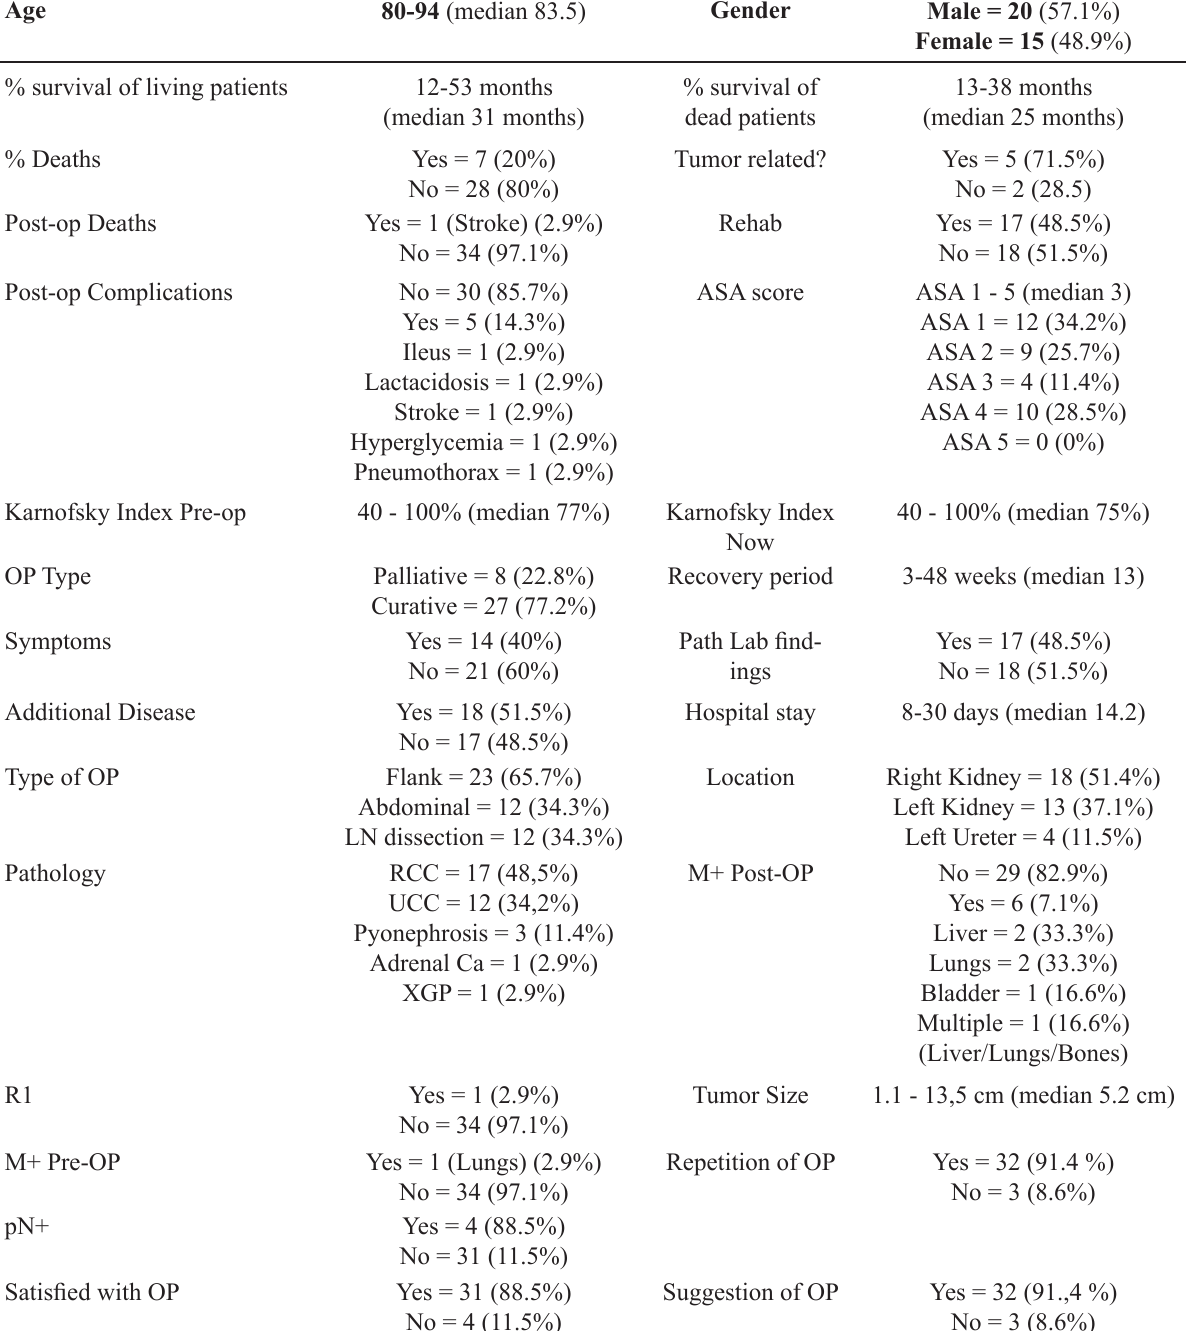
Table 1 – Patient characteristics, intraoperative-postoperative data and the subjective opinion of patients regarding the